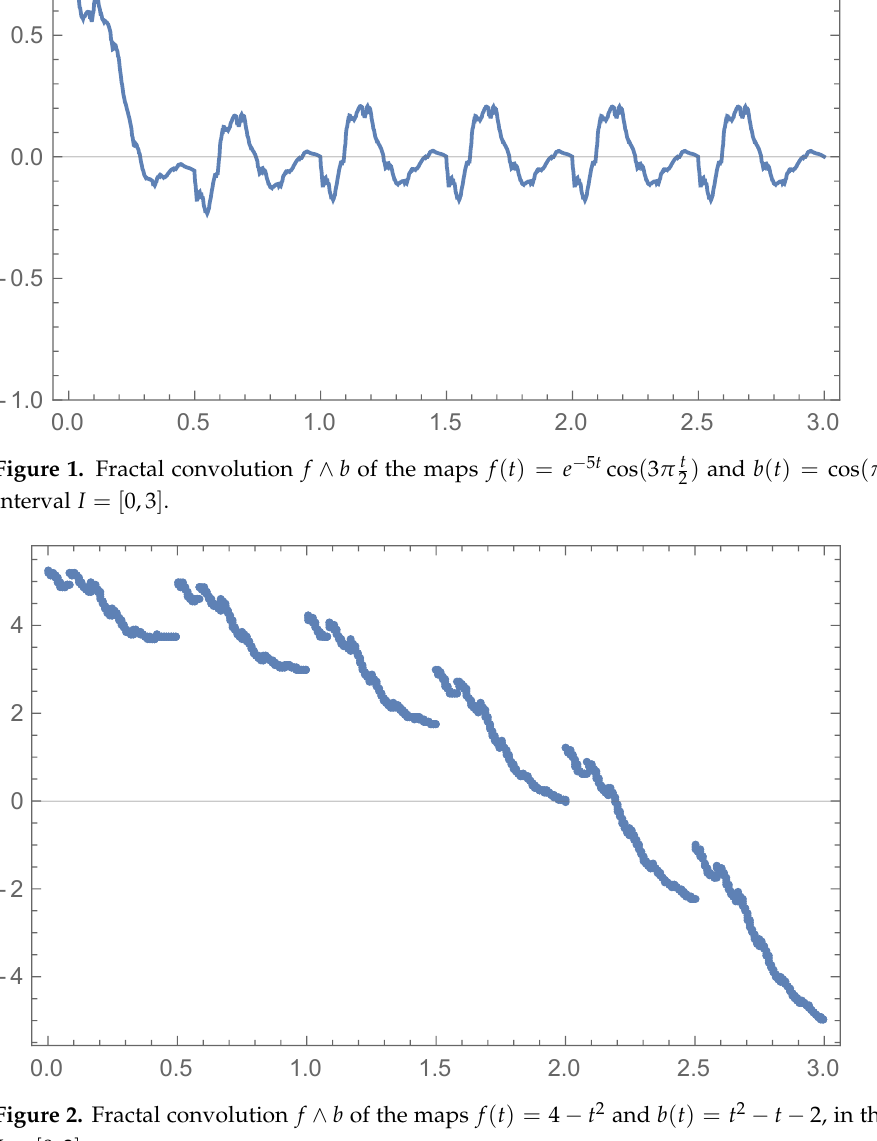
Figure 2. Fractal convolution f ∧ b of the maps f ( t ) = 4 − t 2 and b ( t ) = t 2 − t − 2, in the interval I = [ 0,3 ]